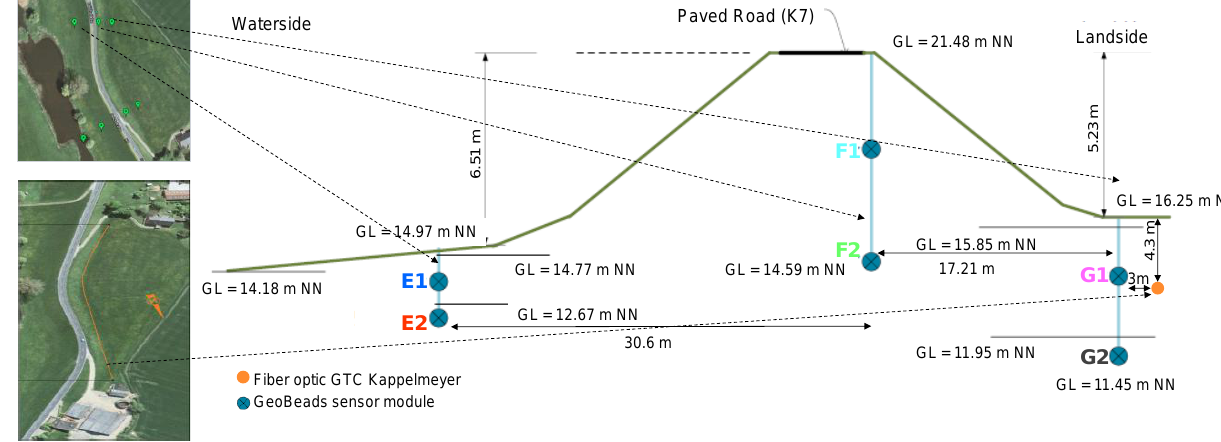
Figure 13. Alert Solutions pore pressure measurements converted to water level [m] in relation to Normaal Amsterdams Peil (NAP) or Amsterdam Ordnance Datum (normal water level in the Netherlands)—Y axis. X axis: number of timestamps, rate—1 h